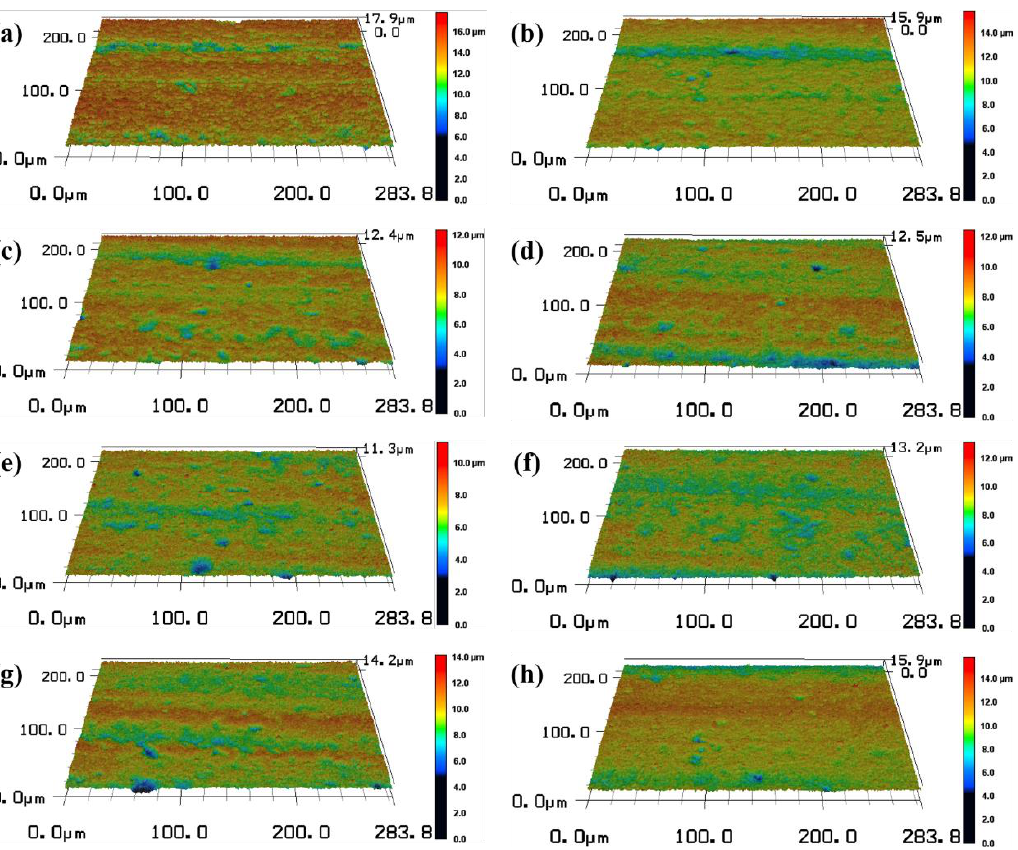
Figure 7. The three-dimensional morphologies of initial surface and the surface after polishing with different pulse energies (magnification 1000). ( a ) The initial surface, ( b ) 15 μJ, ( c ) 20 μJ, ( d ) 25 μJ, ( e ) 30 μJ, ( f ) 35 μJ, ( g ) 40 μJ, ( h ) 45 μ J.